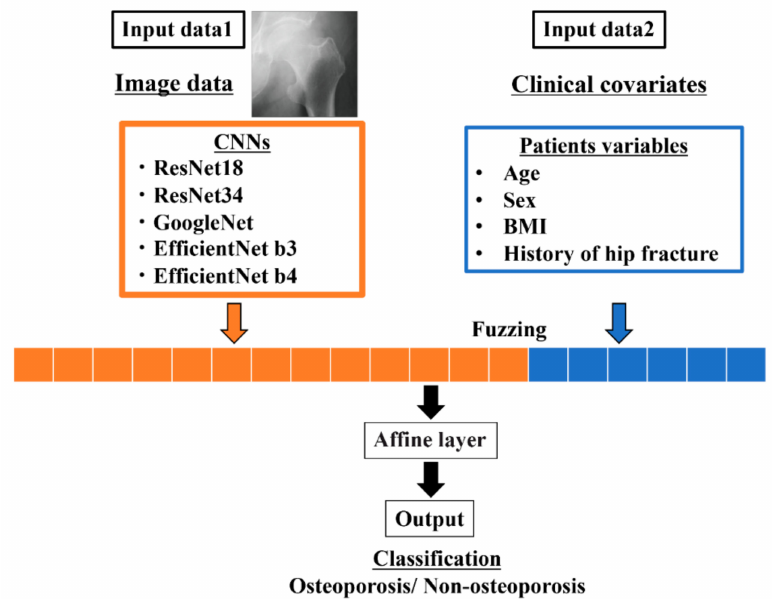
Figure 2. A neural-network model architecture that ensembles image data and clinical